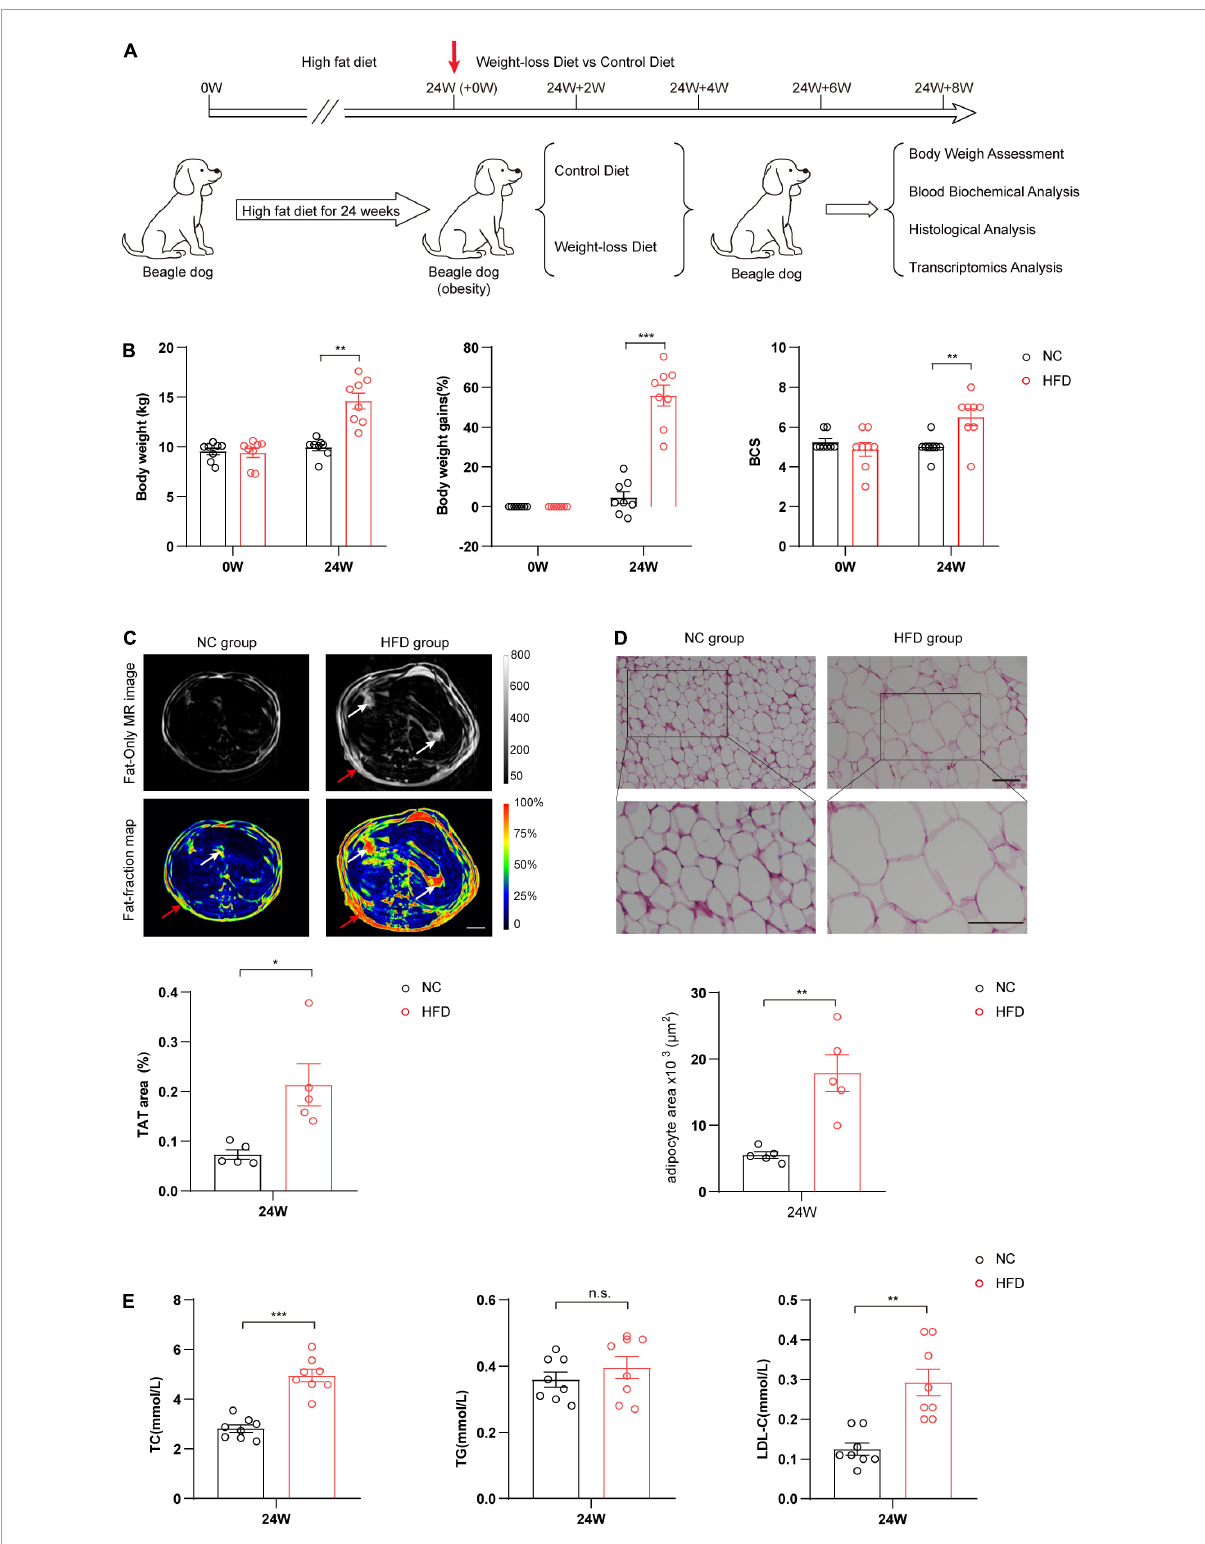
FIGURE1 High-fat diet (HFD) successfully induced obesity in beagle dogs. (A) Schematic diagram of the experimental design process. Beagles were randomly divided into two groups, and then fed a HFD or a normal chow diet (NC) for 24 weeks. The obese dogs were evaluated by